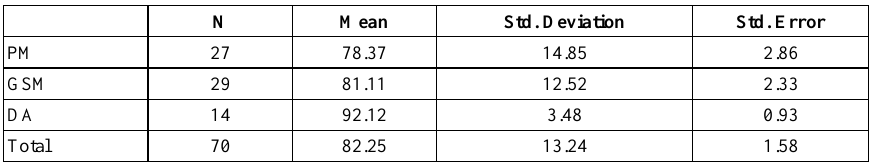
Table 2. Descriptive statistics of quiz scores